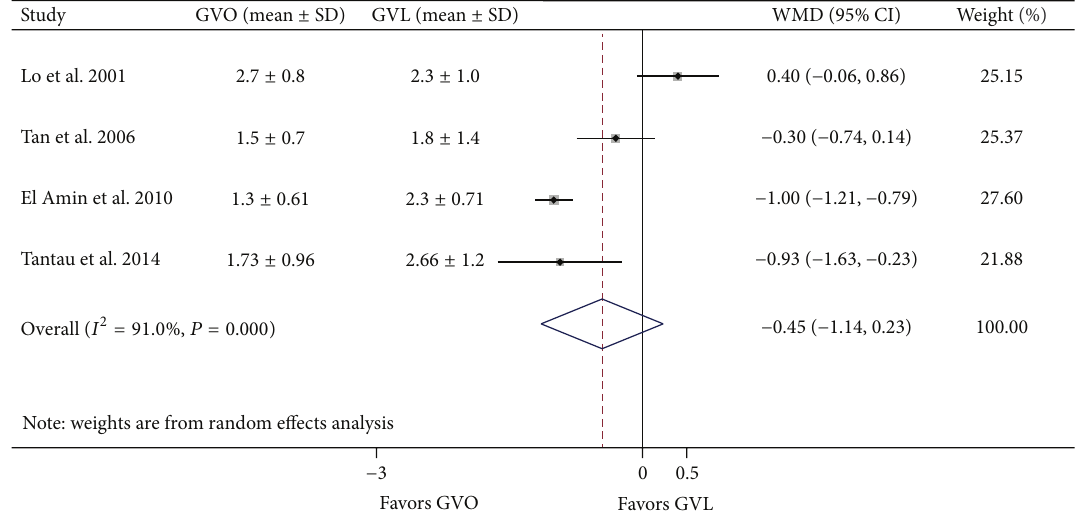
Figure 7: Comparison of number of treatment sessions in the GVO and GVL groups. GVO, cyanoacrylate injection; GVL, band ligation; CI, confidence interval; WMD, weighted mean